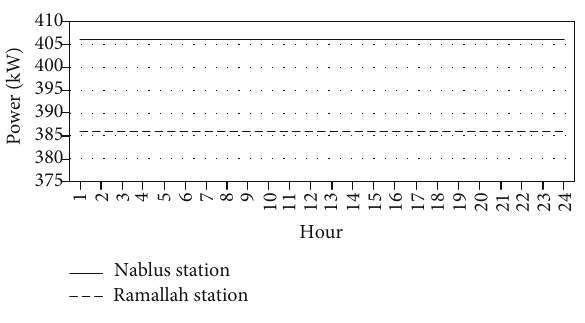
Figure 7: Charging demand for the second scenario.